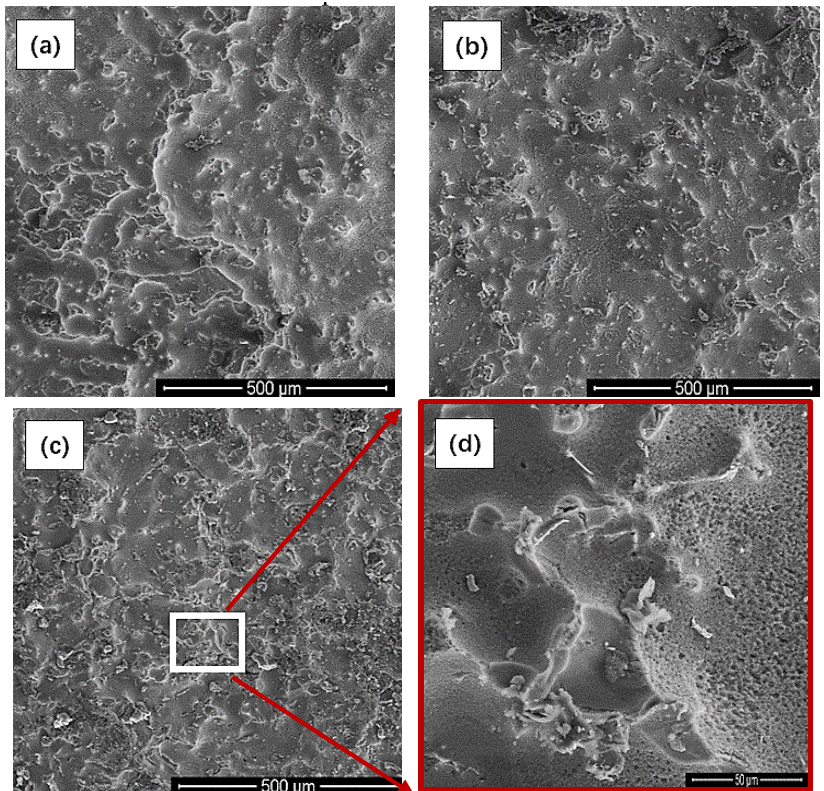
Figure 10. Morphologies of the alloys immersed for 3 d to remove corrosion products: ( a ) Mg-1Nd alloy, ( b ) Mg-2Nd alloy, ( c ) Mg-3Nd alloy; ( d ) local magnification of Mg-3Nd alloy picture.